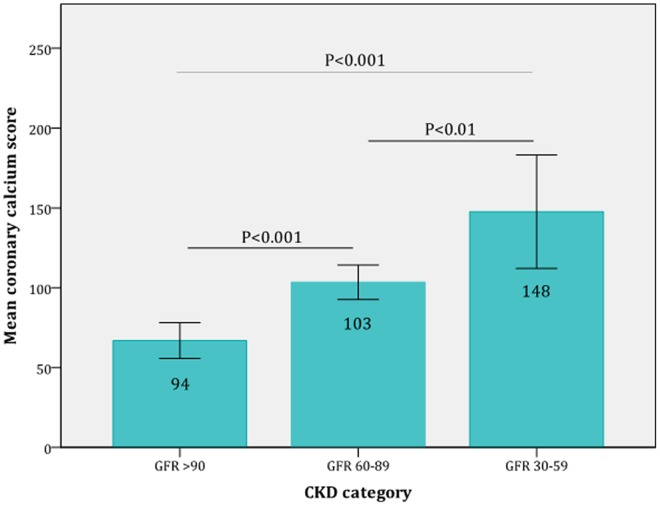
Mean coronary calcium score in the different CKD-categories.The graph clearly shows that the mean calcium score increased significantly with decreasing renal function.